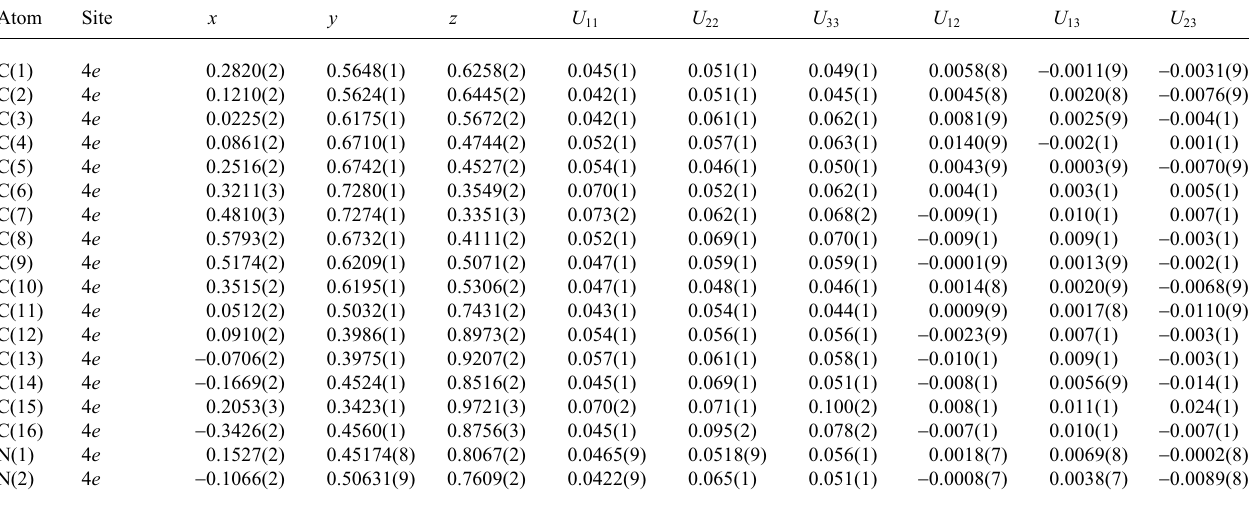
Table 3. Atomic coordinates and displacement parameters (in Å 2 )